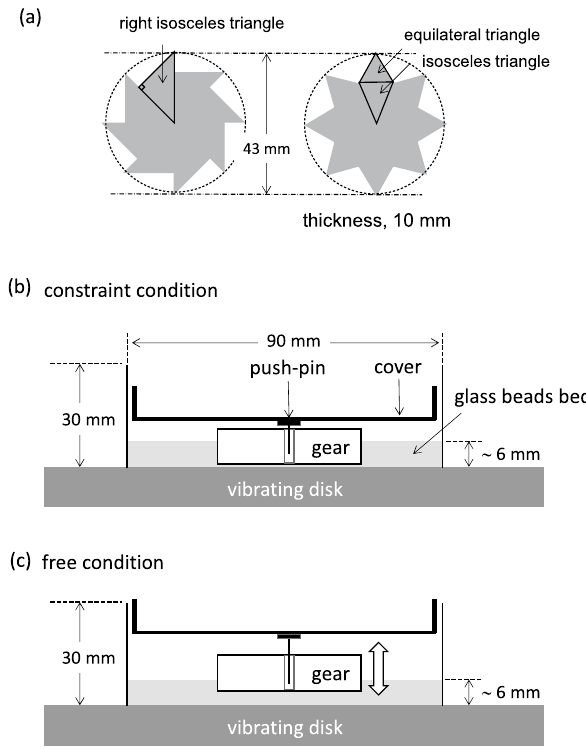
Figure 1. Schematic representation of experimental setup. ( a) Asymmetric and symmetric gears; ( b , c ) setup for constraint ( b ) and free ( c )